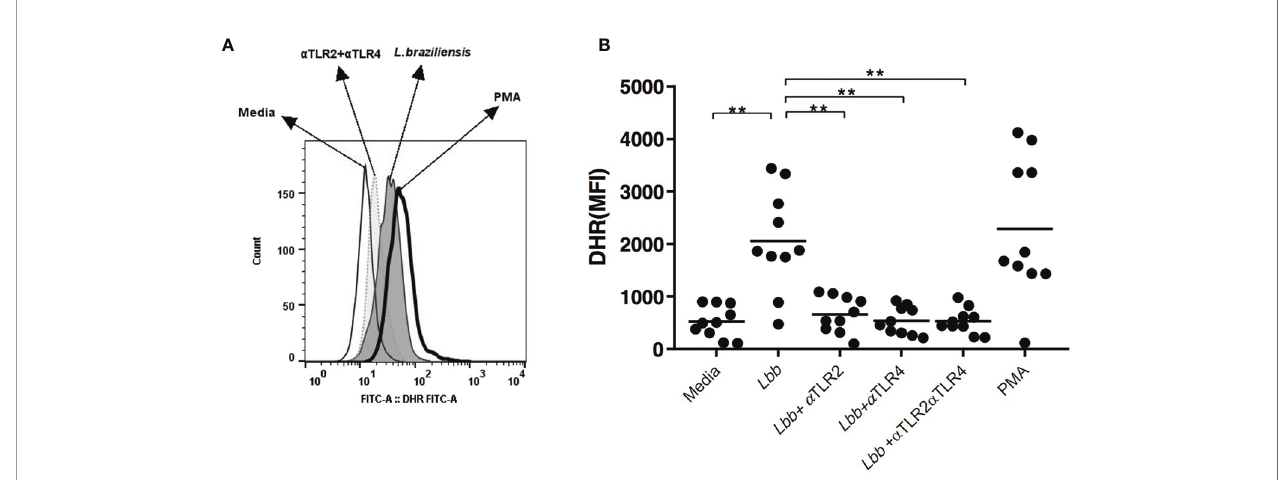
FIGURE 3 | Neutralization of TLR2 and TLR4 interferes with oxidative burst in CL monocytes. Peripheral blood monocytes from CL patients (n = 10) were treated with anti-TLR2 and anti-TLR4 antibodies, infected with L. braziliensis (5:1) for 25 minutes. Cells were labeled with anti-CD14 antibody for monocyte characterization. Respiratory burst was measured via DHR123 oxidation by fl ow cytometry. PMA was used as a positive control (A) . Data plots represent median mean fl uorescence intensity (MFI) values (B) . Wilcoxon signed-rank test; **p<0.01.